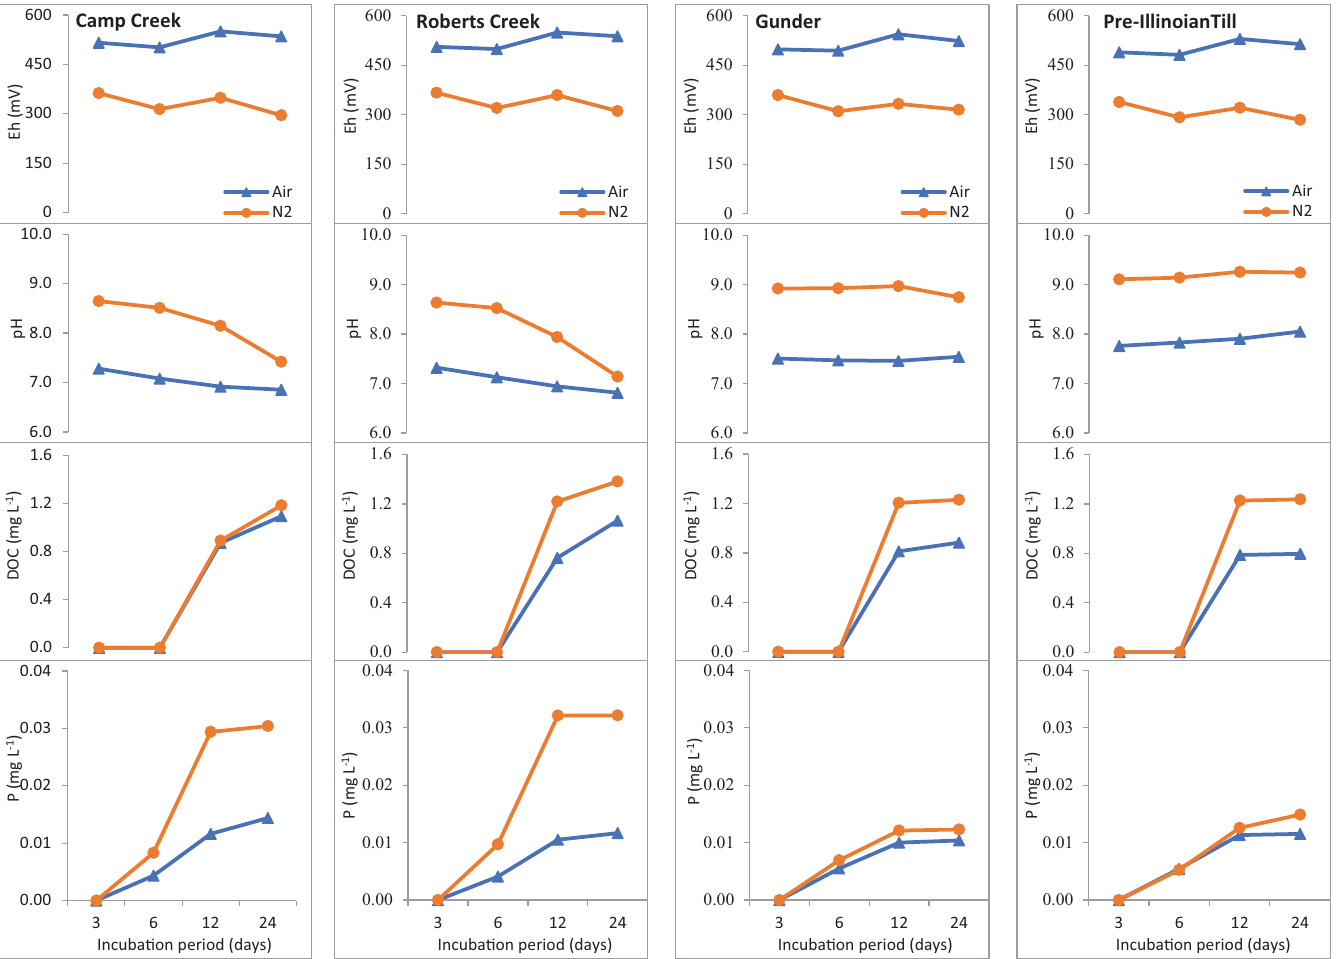
Fig 6. Dissolved P, dissolved organic carbon (DOC), pH, and redox potential (Eh) under aerobic (air purging, - Δ -) and anaerobic (N 2 purging, - � -) environments in the solution for each sediment during the 24 days of incubation. Each point represents the mean of three replicates.